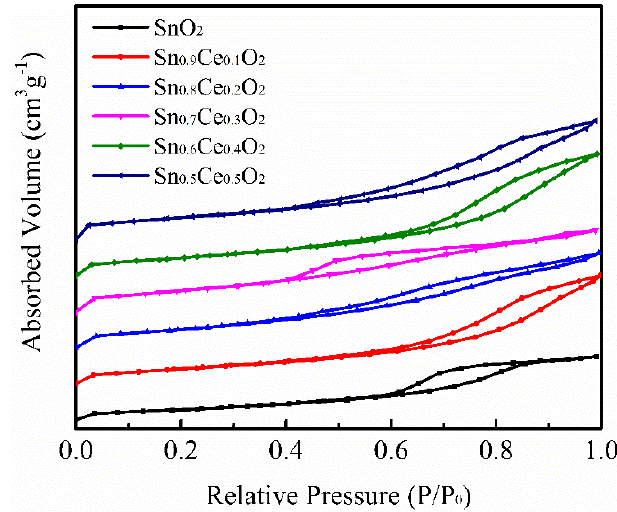
Figure 5. Nitrogen adsorption–desorption isotherms of the SnO 2 and Sn x Ce 1-x O 2 fiber catalysts.